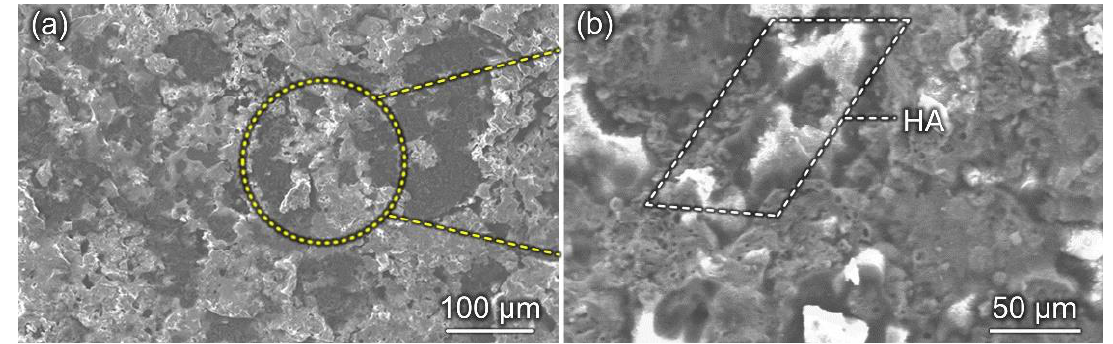
Figure 4. Tensile fracture morphology of the sample: ( a ) ×200; ( b ) ×500.